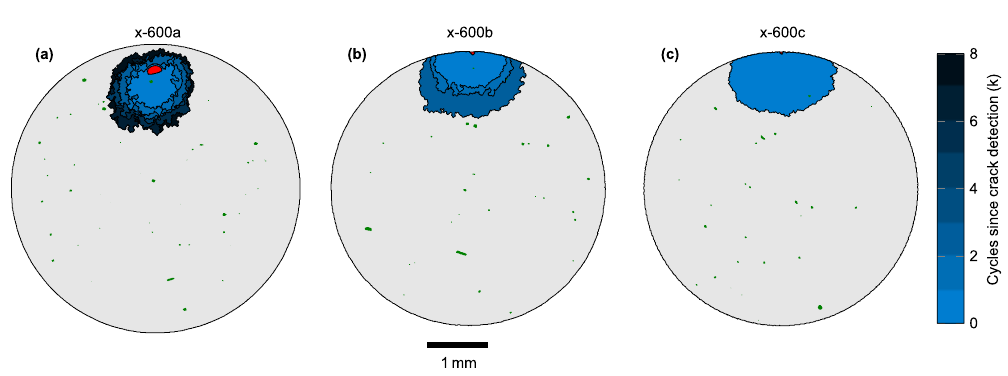
Figure 5. Fatigue crack initiation detected by CT. - Fatigue cracks (blue), the pore that initiated the crack (red), and all other pores (green) within a 1 mm thick slice centred around the plane of the crack, detected by CT after ( a ) 70 k, ( b ) 100 k and ( c ) 120 k cycles. In ( a ) and ( b ) multiple crack tidemarks show the detected crack size every 1 k cycles following first detection of the